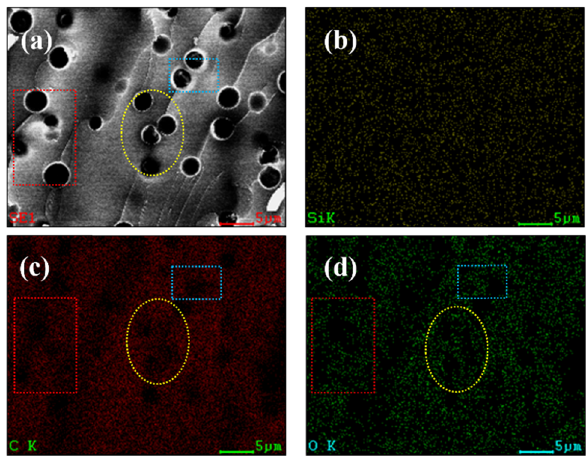
Figure 14: EDS analysis of 8% POSS - PR. ( a ) SEM image of 8% POSS - PR; ( b ) Si mapping of image “ a; ” ( c ) C mapping of image “ a; ” ( d ) O mapping of image “ a. ”